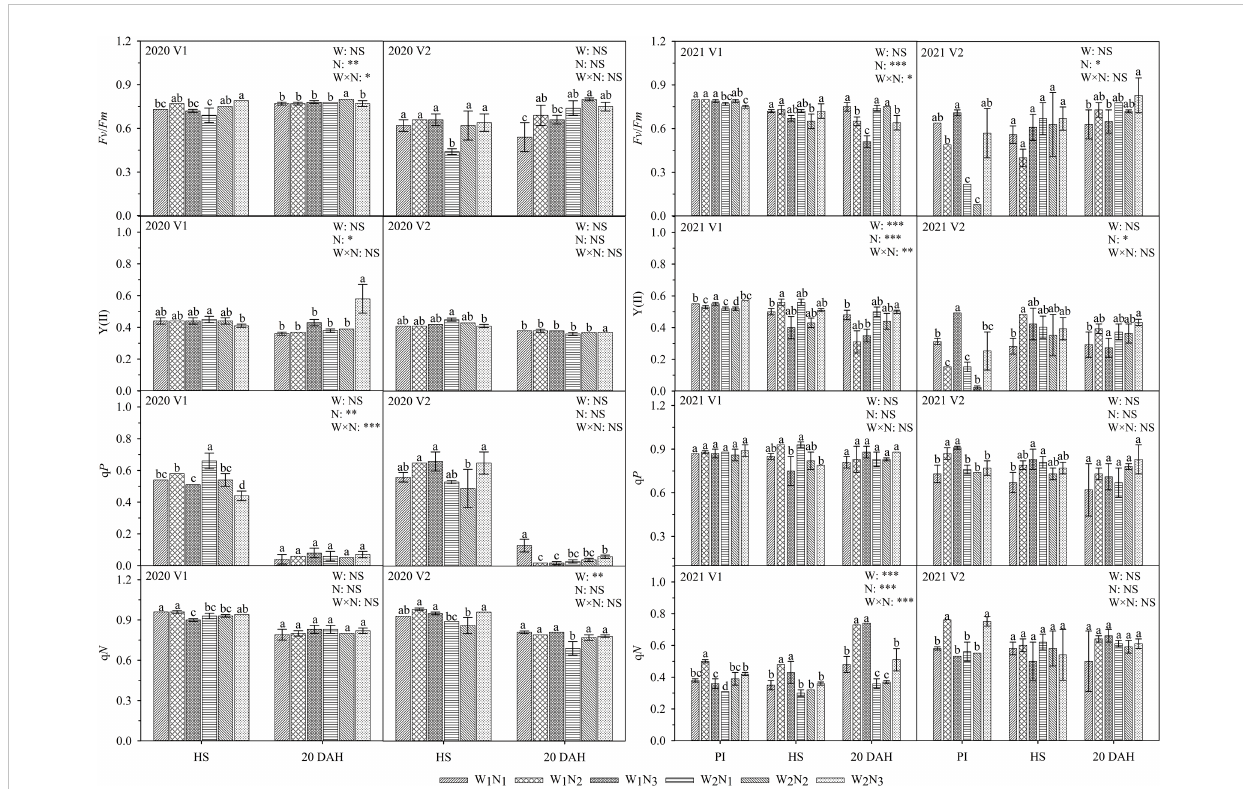
FIGURE 5 Effects of different water and nitrogen treatments on chlorophyll fl uorescence in rice leaves at different growth stages. The data are presented as the means of three replicates (n = 3). Error bars indicate standard error (SE). W 1 and W 2 represent limited irrigation (10200 m 3 ·hm -2 ) and de fi cit irrigation (8670 m 3 ·hm -2 ), while N 1 , N 2 , and N 3 represent different ratios of seedling fertilizer:tillering fertilizer:panicle fertilizer:grain fertilizer (30%:50%:13%:7%; 20%:40%:30%:10%; and 10%:30%:40%:20%, respectively). PI, HS, and 20 DAH represent panicle initiation, heading stages, and 20 days after heading, respectively. V1 and V2 represent T-43 and Liangxiang-3, respectively. * represents a signi fi cant difference at the 0.05 level; ** represents a signi fi cant difference at the 0.01 level; *** represents a signi fi cant difference at the 0.001